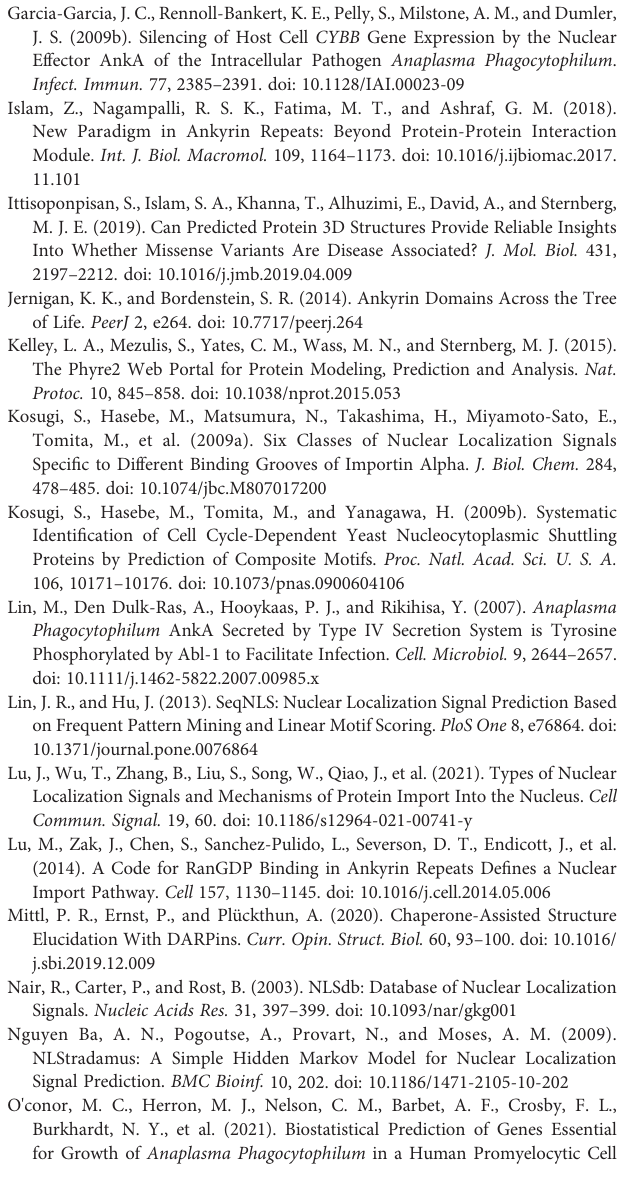
Supplementary Figure 2 | The AnkA N-terminal 300 residue structure was modeledbyalignmentusingPhyre2toidentifythebestmatch,4RLV(ANK2).Usingthis model, the location and impact of changes in individual residues was assessed using Missense3D. The speci fi c insertions are shownonthe c4RLV models of AnkA ARs 1-4 by AnkA AR, and labeled with the speci fi c residue change. Note that the model c4RLV model structure results in two non-contiguous templates resulting from a large gap in 4RLV compared to AnkA. AR1 and 2 are on one template; AR3 and 4 on a different template. No residue change was predicted to cause any structural damage. Supplementary Figure 3 | Alignment of AnkA modeled by Phyre2 on 4RLV. ARs in AnkA are shown in yellow highlights, those in 4RLV are shown in green. Dashes indicate gaps in alignment. Note that AnkA AR2 spans a large gap in 4RLV. AnkA ARs 1-4 correspond to ARs 2, 5/20, 21, and 22 in 4RLV. Supplementary Figure 4 | Detailed alignment of AnkA N-terminal 300 residues byPhyre2 to4RLVshowingpredicted secondary structurefor both AnkAand 4RLV templates. Yellow highlights show AnkA